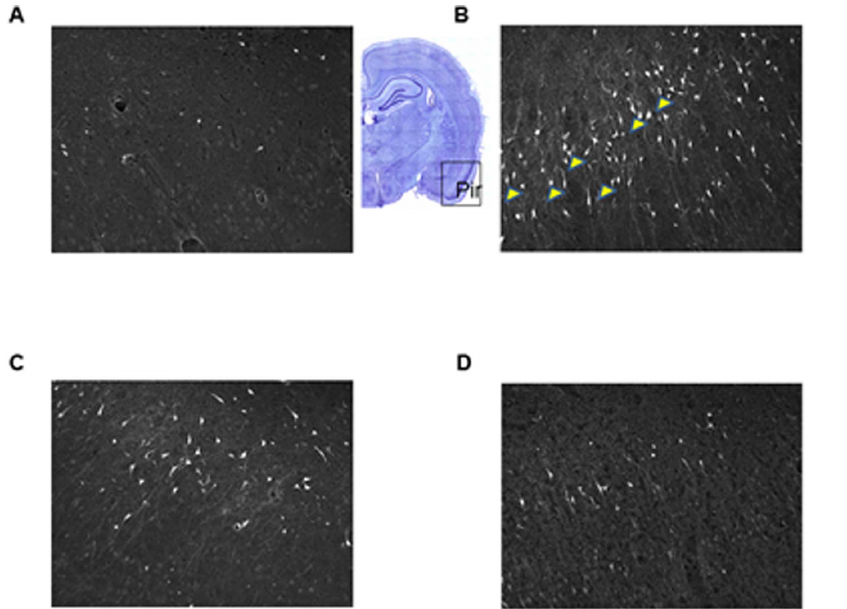
Figure 2. Administration with ( 2 )-phenserine but not posiphen thirty minutes prior to soman exposure reduces neuronal cell death in the vulnerable piriform cortex. Representative photomicrographs of the piriform cortex stained with Fluorojade C staining (A–D, magnification 200 6 ). Animals were injected with saline (A), a single dose of posiphen (1 mg/kg iv) [C] or ( 2 )-pheserine (1 mg/kg iv) [D] thirty min prior to injection of soman (B). Animals were euthanized 24 hours after soman exposure. The piriform cortex (Pir) is outlined in the coronal section. Fluorojade C-positive degenerating neurons are indicated by the arrowheads. There was no statistically significant difference between groups of animals injected with saline and administration of either posiphen or ( 2 )-phenserine in the absence of soman and are not shown.